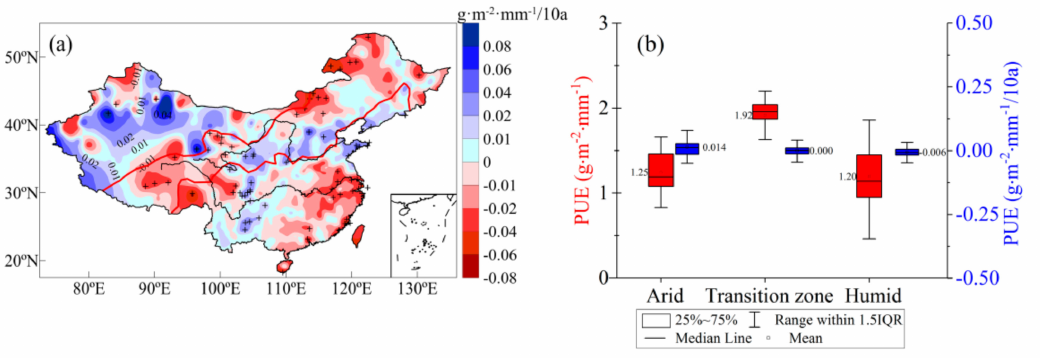
Figure 10. Precipitation-use efficiency (PUE) trend (1960–2017) and ( a ) distribution of average values and trends in the sub regions and ( b ) +indicates that the trend was significant at the 0.05